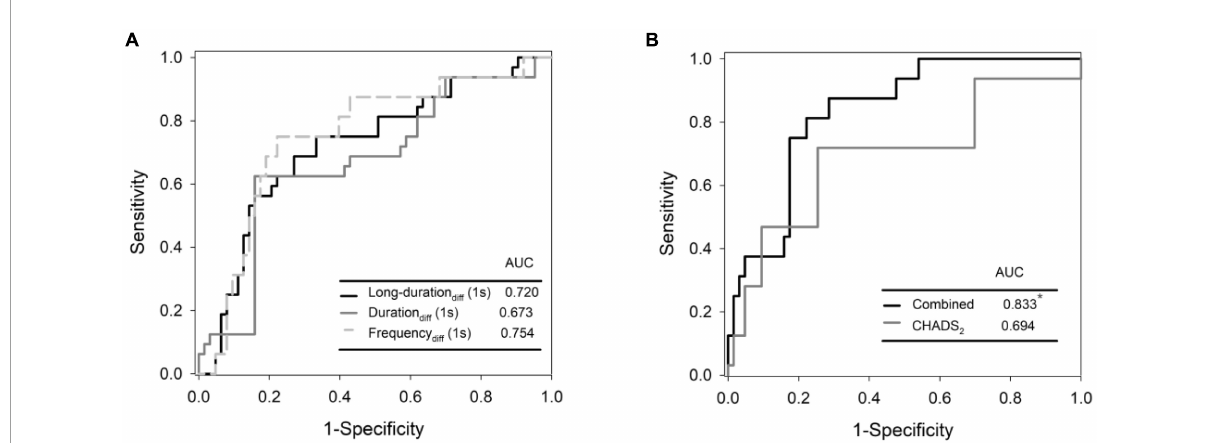
FIGURE5 Receiver operating characteristic (ROC) curves from logistic regression models with CHADS 2 score, pre-ablation 1-s frequency of skin SKNA, and post-ablation 5-s frequency of skin SKNA predicting the 3-month recurrence of AF (A) and the derived differences between pre- and post- ablation of long-duration, bursting frequency, and duration in combination with CHADS 2 can better predict recurrence (B) . ∗ Denotes most